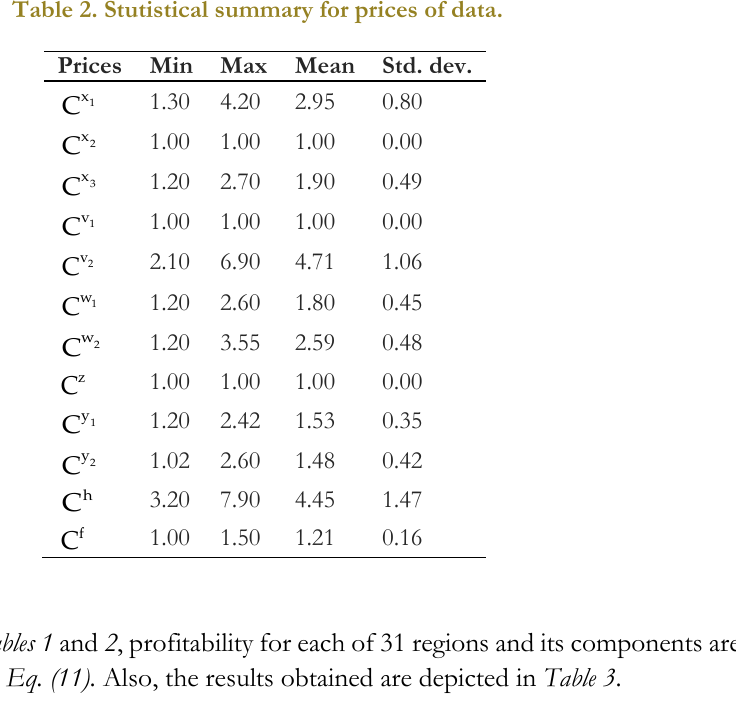
Table 2. Stutistical summary for prices of